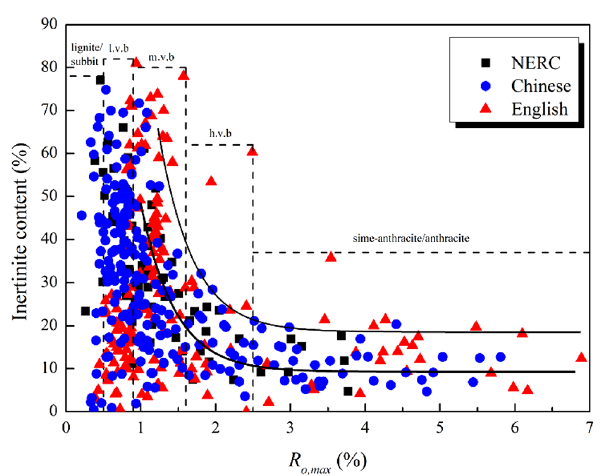
Fig. 10 Variation of Intertinite content with vitrinite reflectance R o ; max . (Data size: NERC-64, Chinese (Ceglarska-Stefan´ska and Brzo´ska 1998; Yu et al. 2004; Chang et al. 2006; Qin et al. 2007; Faiz et al. 2007a, b; Chang et al. 2008; Jiang et al. 2012; Lin et al. 2013; Xiao et al. 2016)-233, English(Giuliani et al. 1991; Crosdale et al. 1998; Bustin and Clarkson 1998; Marecka and Mianowski 1998; Laxminarayana and Crosdale 2002; Busch et al. 2003; Mastalerz et al. 2004; Busch et al. 2006; Hildenbrand et al. 2006; Busch et al. 2007; Majewska and Zie˛tek 2007; Siemons et al. 2007; Astashov et al. 2008; Day et al. 2008; Yu et al. 2008a, b; Mazumder and Wolf 2008; Pone et al. 2009; Radlin´ski et al. 2009; Majewska et al. 2009; Gensterblum et al. 2010; Battistutta et al. 2010; He et al. 2010; Day et al. 2011; Kim et al. 2011; Maphala and Wagner 2012; Sakurovs 2012; An et al. 2013; Cai et al. 2013a, b; Dutka et al.